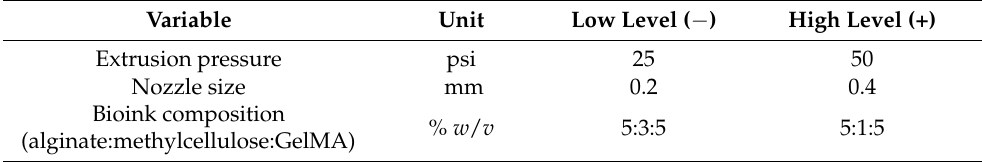
Table 3. Values at each level of